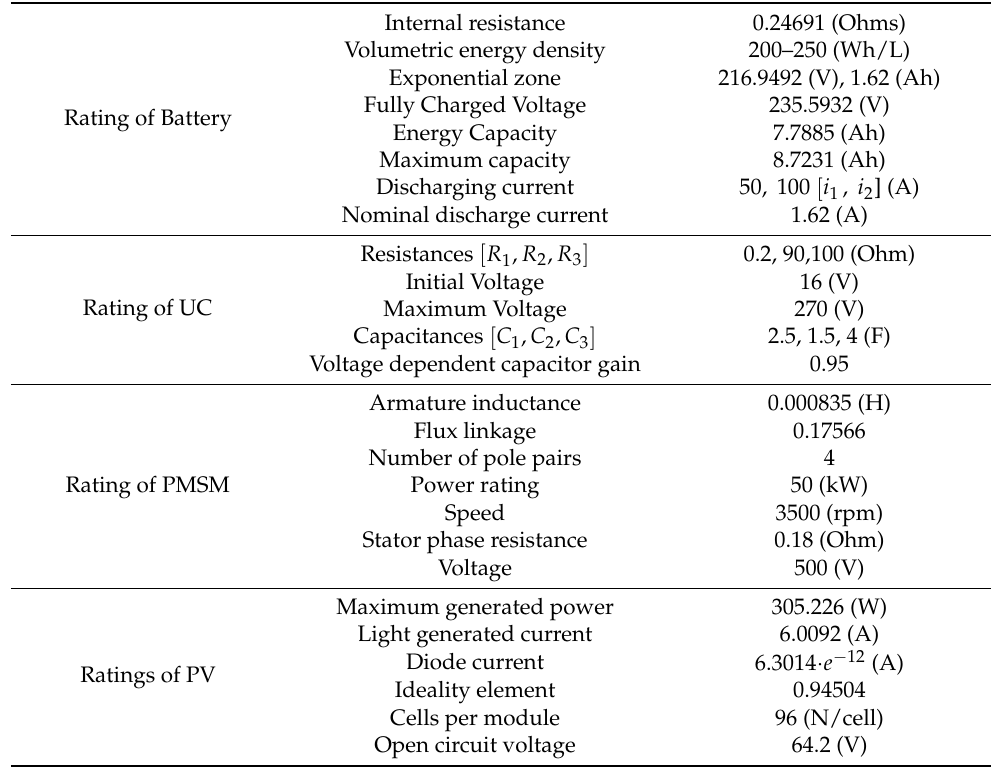
Table 1. Overall results of the proposed ANN–AOA